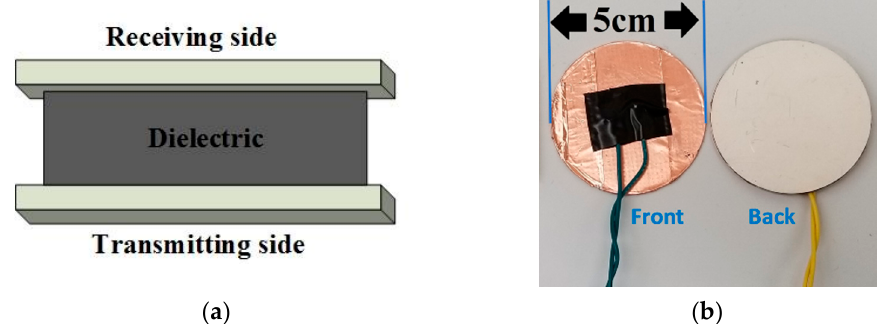
Figure 3. Circular capacitive-coupling plates manufactured for hardware tests in